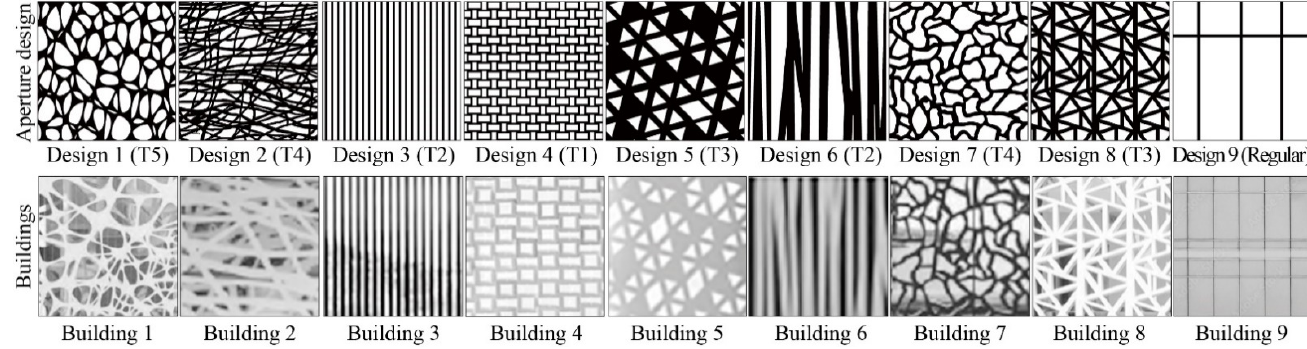
Figure 1. Nine aperture designs (the upper row) and the original buildings (the lower row). Building